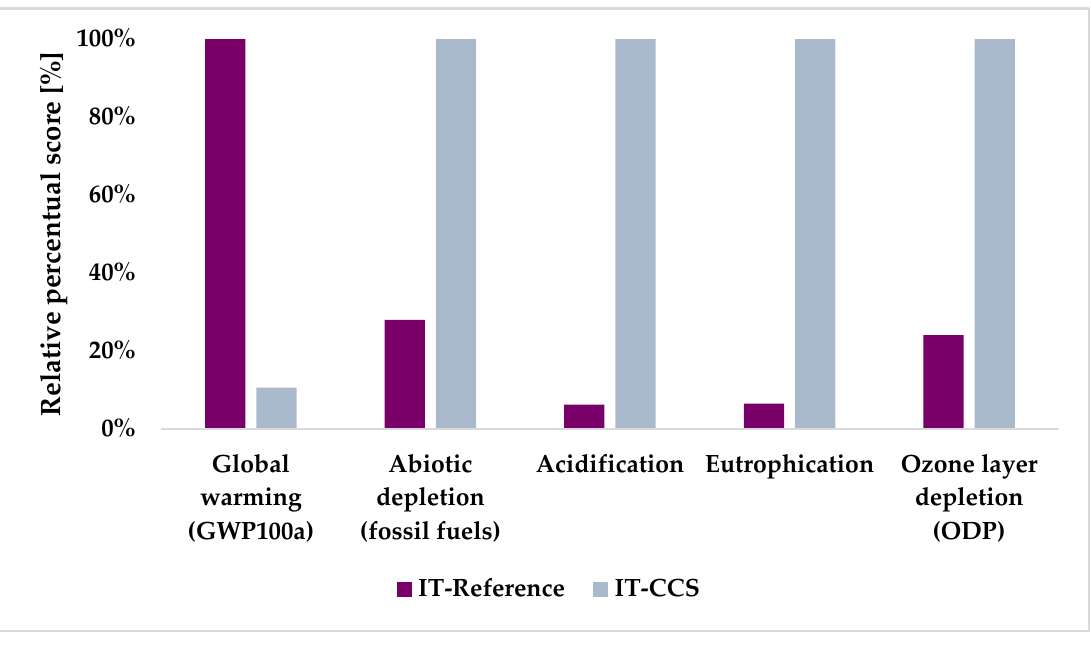
Figure 3. Impact category scores for the Italian case study in the CCS scenario.